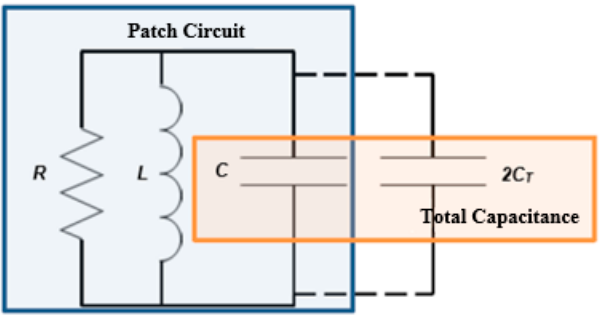
Figure 7. Equivalent circuit of P-ESPAR antenna [16].